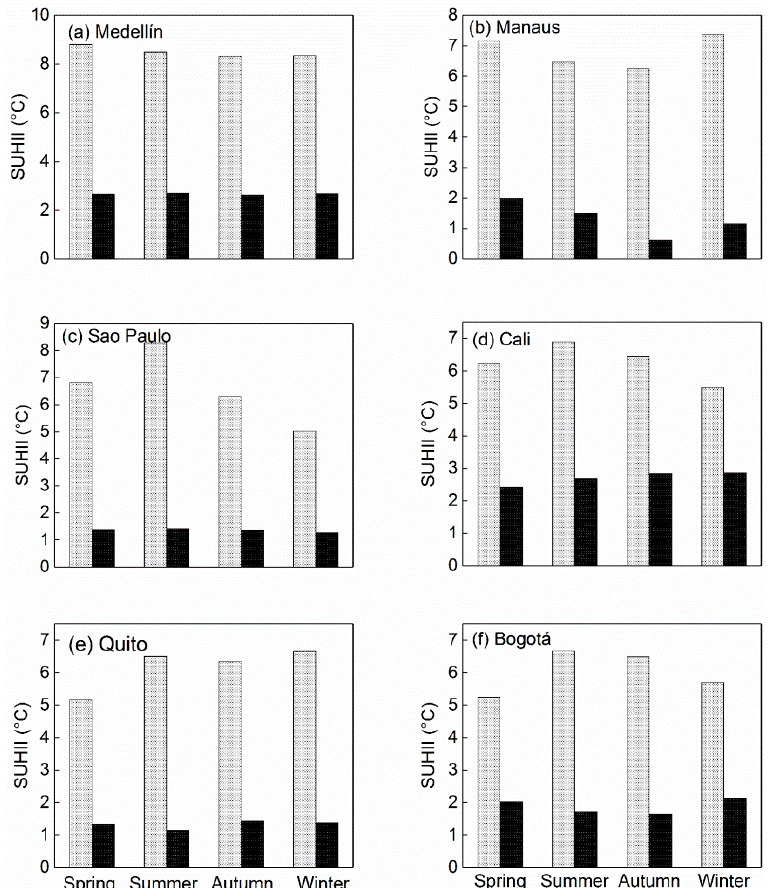
Figure 7. The average SUHII values from 2003–2016 for six cities: Medellín (Colombia), Manaus (Brazil), São Paulo (Brazil), Cali (Colombia), Bogotá (Colombia), and Quito (Ecuador). The gray and black columns represent the daytime and night-time SUHII, respectively.